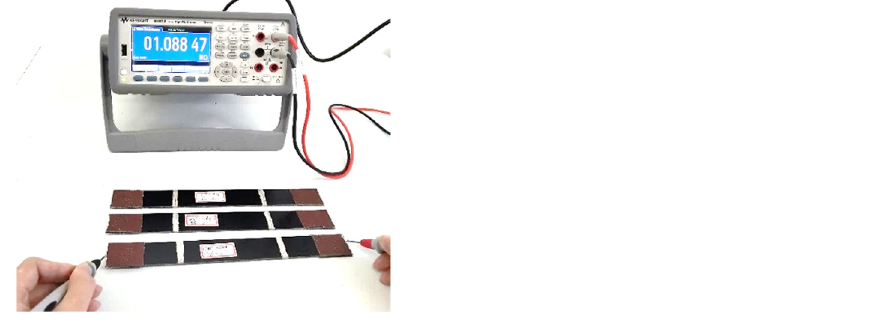
Figure 3 . Electrical resistance measurements of the CNM-incorporated GFRP composites.